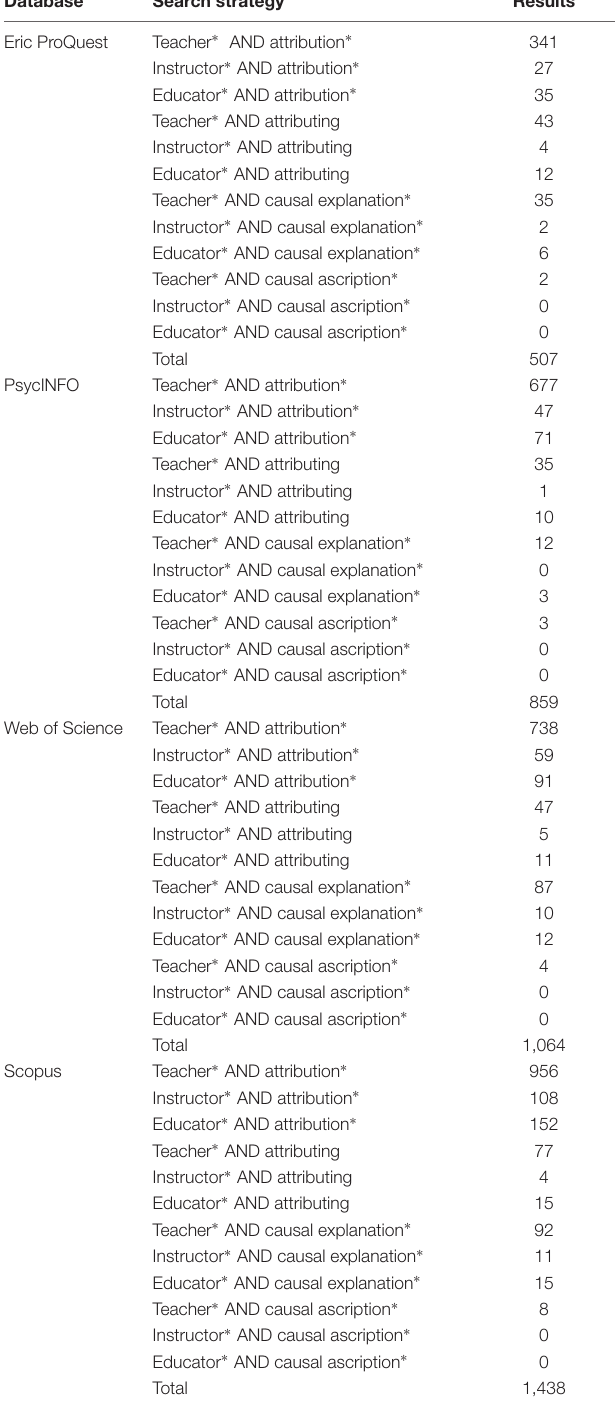
Figure 1 for details on search terms and results).